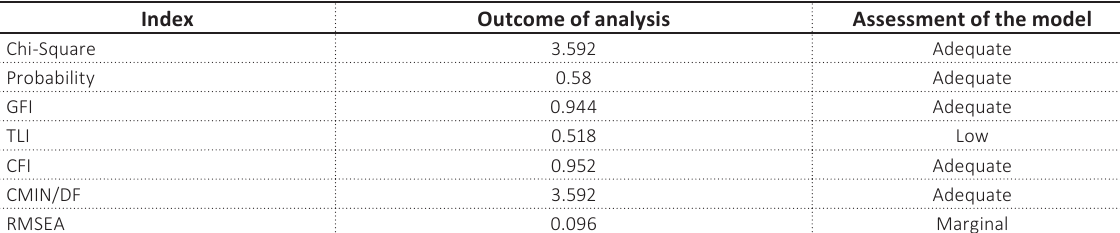
Table 3. Outcome of confirmatory factor analysis